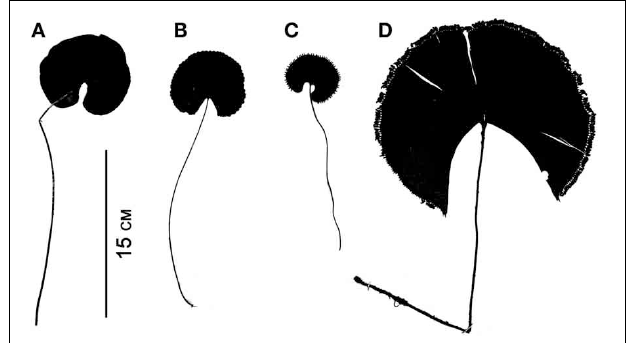
FIGURE 7 | Parallelism in four simple-leaved ferns belonging to different families. (A) Lindsaea cyclophylla (Lindsaeaceae). (B)